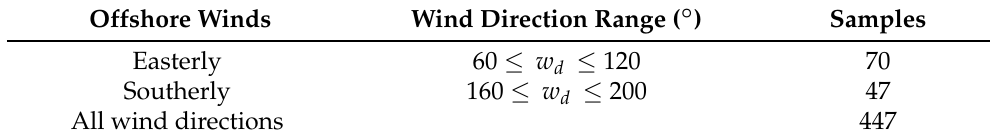
Figure 4. Wind rose computed from DWD data for the wind speed at 10 m height around the cluster N-4 location. Table 1. Offshore wind directions, the corresponding interval and samples considered for the